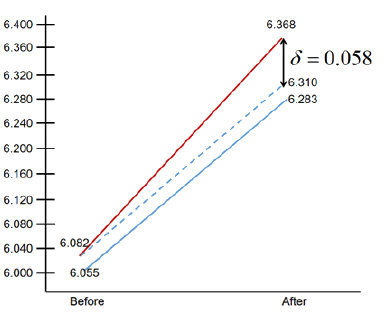
Blue line: control group, Red line: experimental group, Dashed line: experimental group’s original tendency Figure 5. Difference-in-differences estimation results: Completion of luxury housing construction as the differentiation